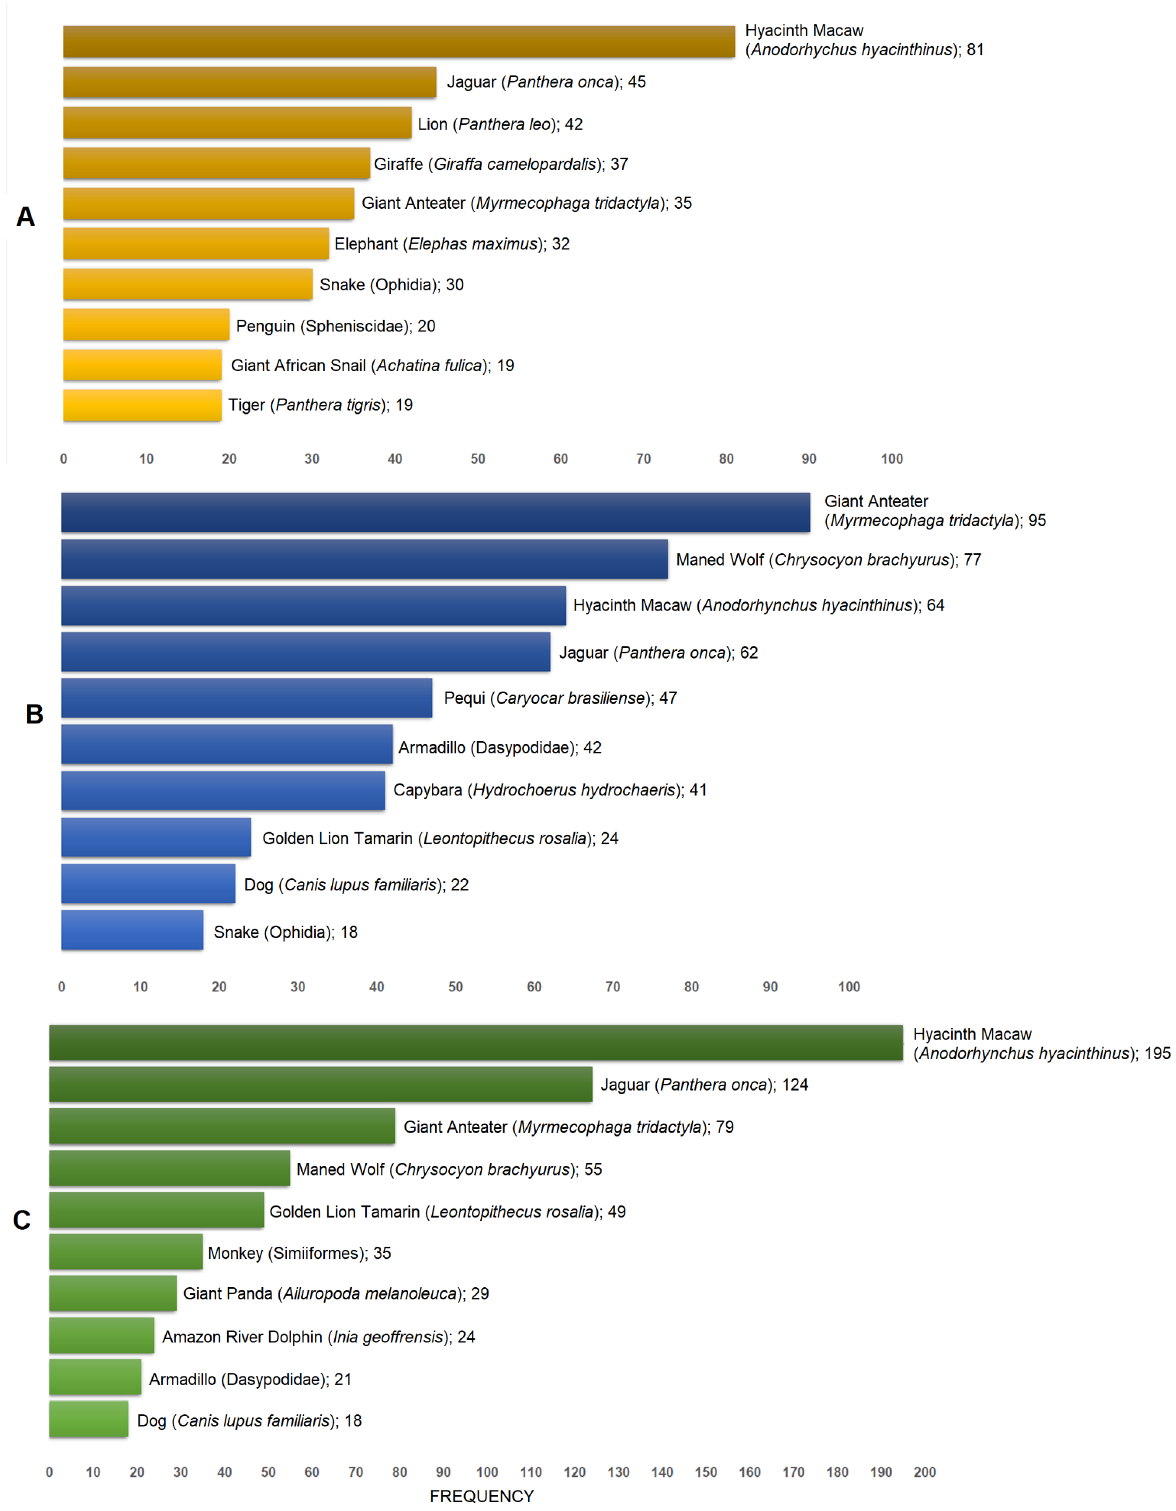
Figure 1. Ranking of species cited by the students as examples of a) exotic species, b) Brazilian native species, and c) species that should be primarily